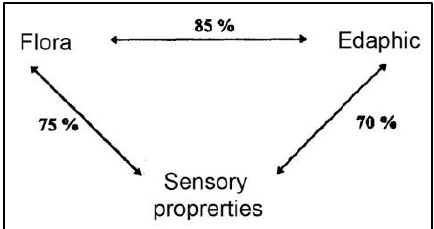
Figure 2. Relationship between edaphic flora characteristic and aroma profile of cheese [13].